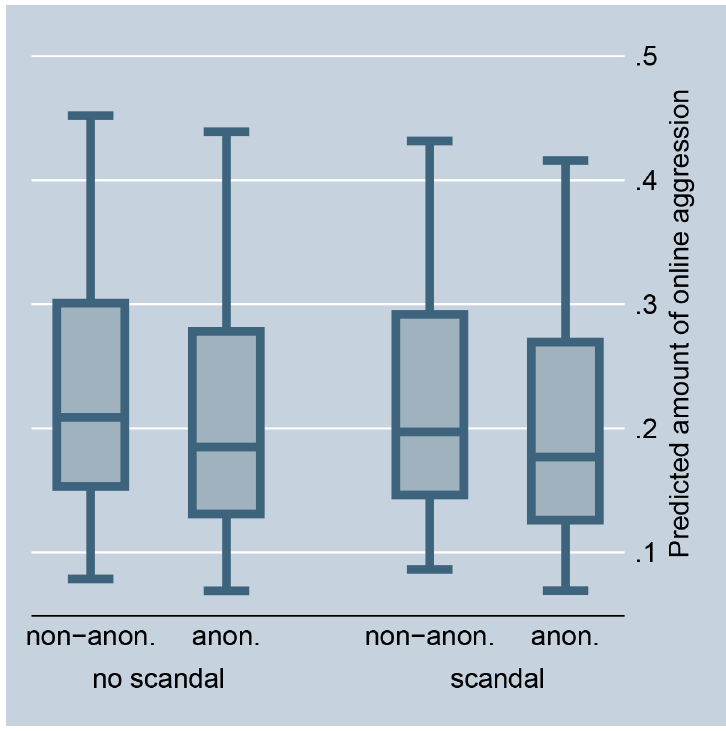
Fig 3. Online aggression dependent on scandal and anonymity (random-effects). Predictions of Table 1, Model 2.